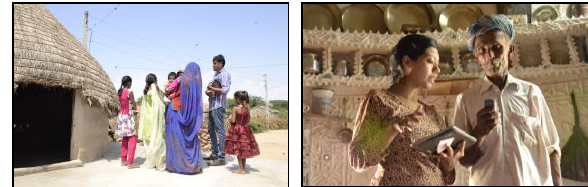
Figure 11. Researchers interacting with residents